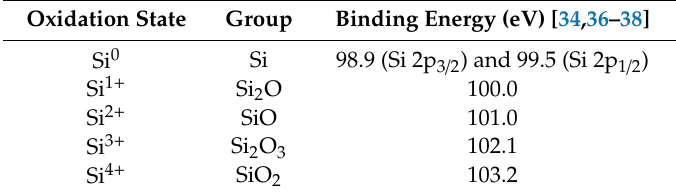
Table 1. Si 2p peak information for different oxidation states (0 to 4).